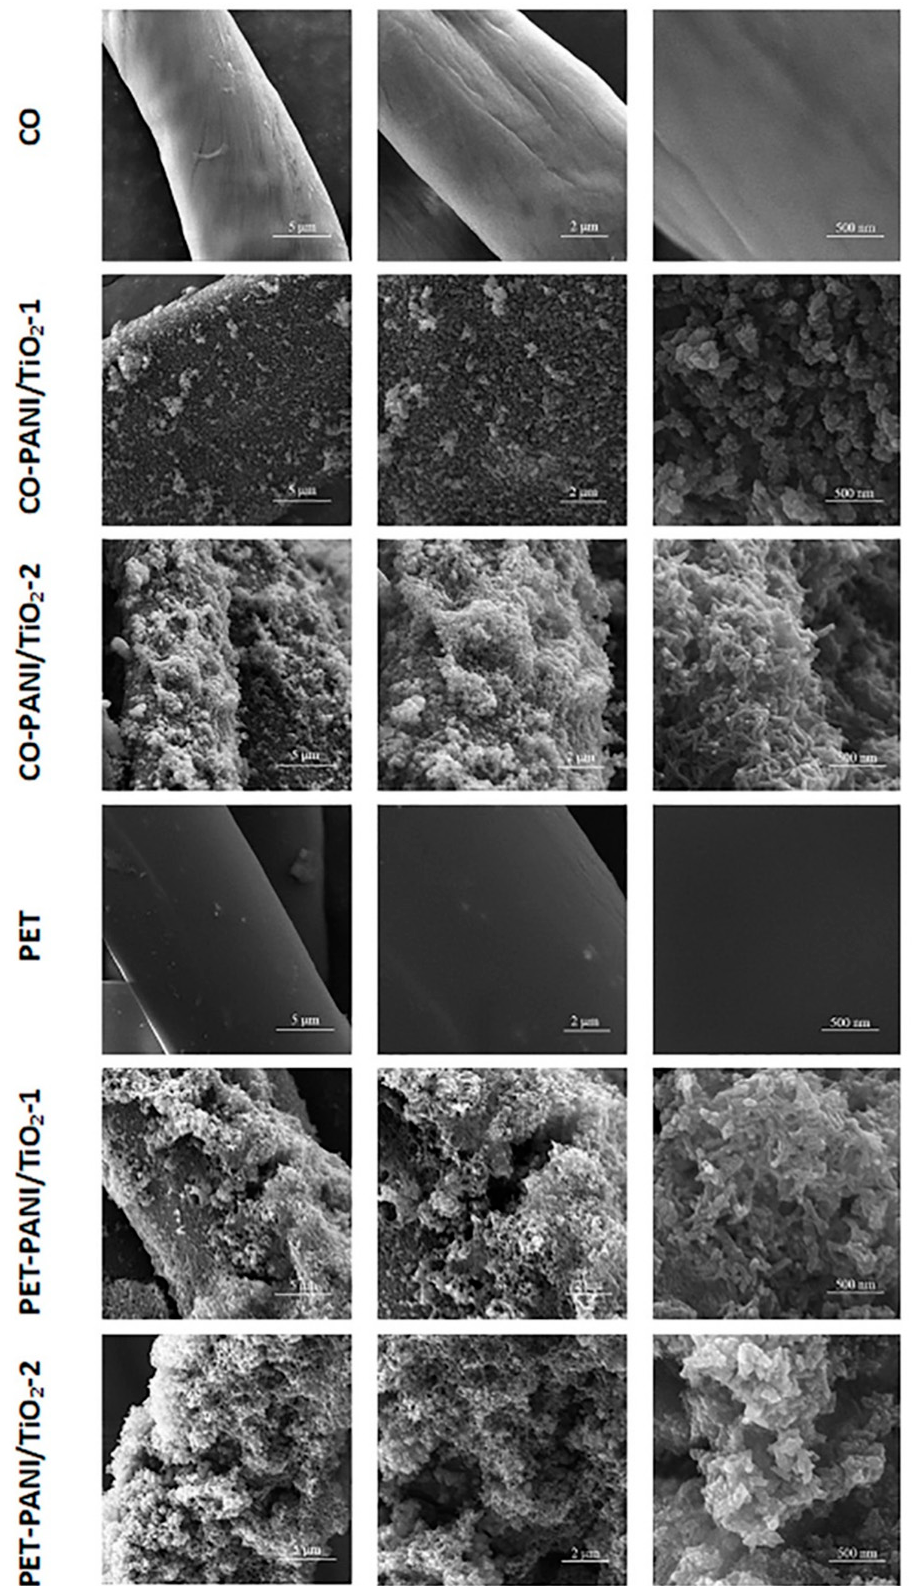
Figure 2. SEM images of control and impregnated CO and PET fibers.